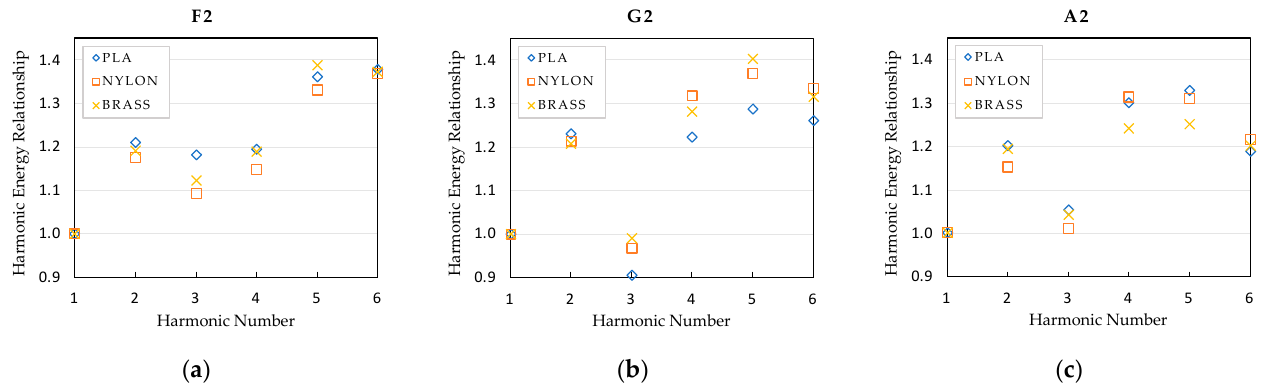
Figure 11. Harmonic energy relationship of the bass register notes: ( a ) E2 note; ( b ) F2 note; ( c ) G2 note.